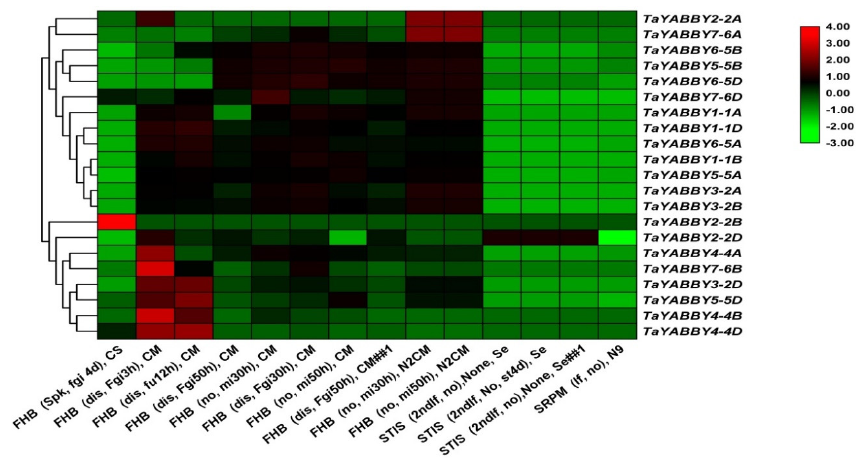
Figure 8. Heatmap of expression profiles for TaYABBY -genes under biotic stresses. The color scale above represents expression values. Green and Red indicated the expression values increased and decreased, respectively, black indicated the expression was unregulated. FHB (Fusarium head blight) inoculation at different time point, STS (Septoria tritici infected Seedlings), SRPM (lf, no), N9 (Stripe rust and powdery mildew time course of infection in Seedlings) respectively. Further detail given in Supplementary sheet 4.